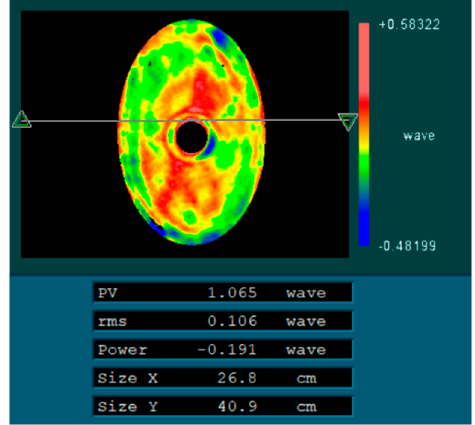
Figure 15. Shape error test results of mirror rotation 180°.